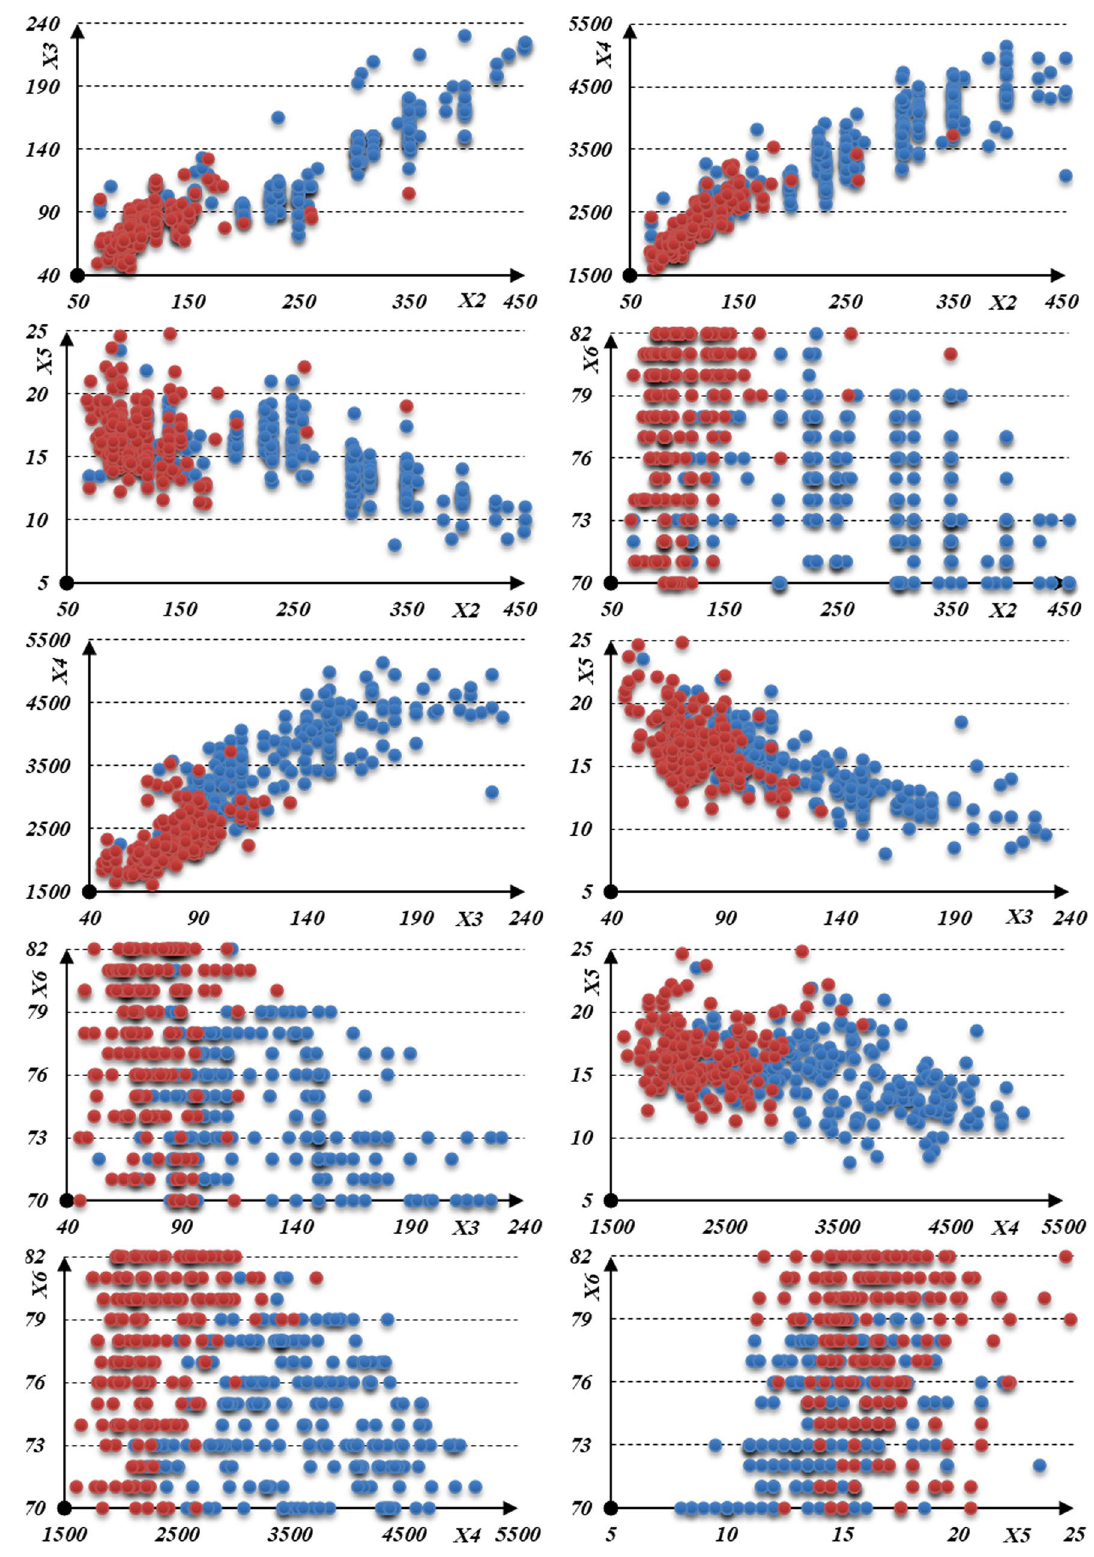
Fig. 2 The plot of attributes against each other according to their classes (blue: 0, red: